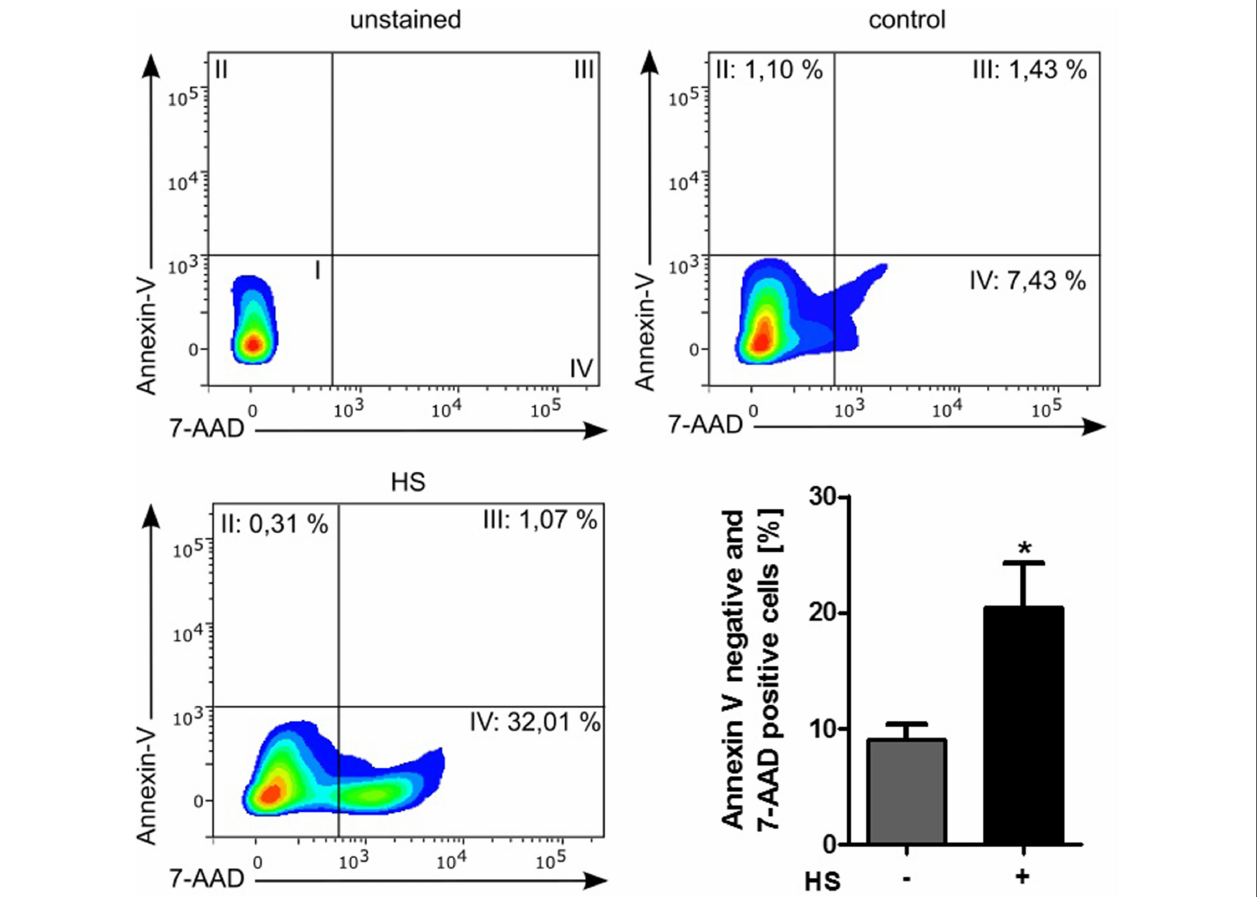
FIGURE 4 | Cell death analysis by using FACS. HL-1 cells exposed to 10 μ g/ml of HS and unstimulated cells (control) were stained with Annexin V and 7-AAD and then analyzed by fluorescence-based flow cytometry. Unstained cells were used for gating the cells. The Annexin V and 7-AAD plots from the gated cells show the populations corresponding to viable cells (both Annexin V and 7-AAD negative, Gate I), early apoptotic cells (Annexin V positive and 7-AAD negative, Gate II), late apoptotic cells (both Annexin V and 7-AAD positive, Gate III), and necrotic cells (Annexin V negative and 7-AAD positive cells, Gate IV). The bar chart represents the percentage (mean (cid:6) SD) of necrotic cells (Annexin V-negative and 7-AAD-positive cells) in unstimulated (control) and HS-treated HL-1 cells, respectively. Triplicate samples for three independent experiments are shown. HS, heparan sulfate; * p < 0.05 control vs. HS-treated HL-1